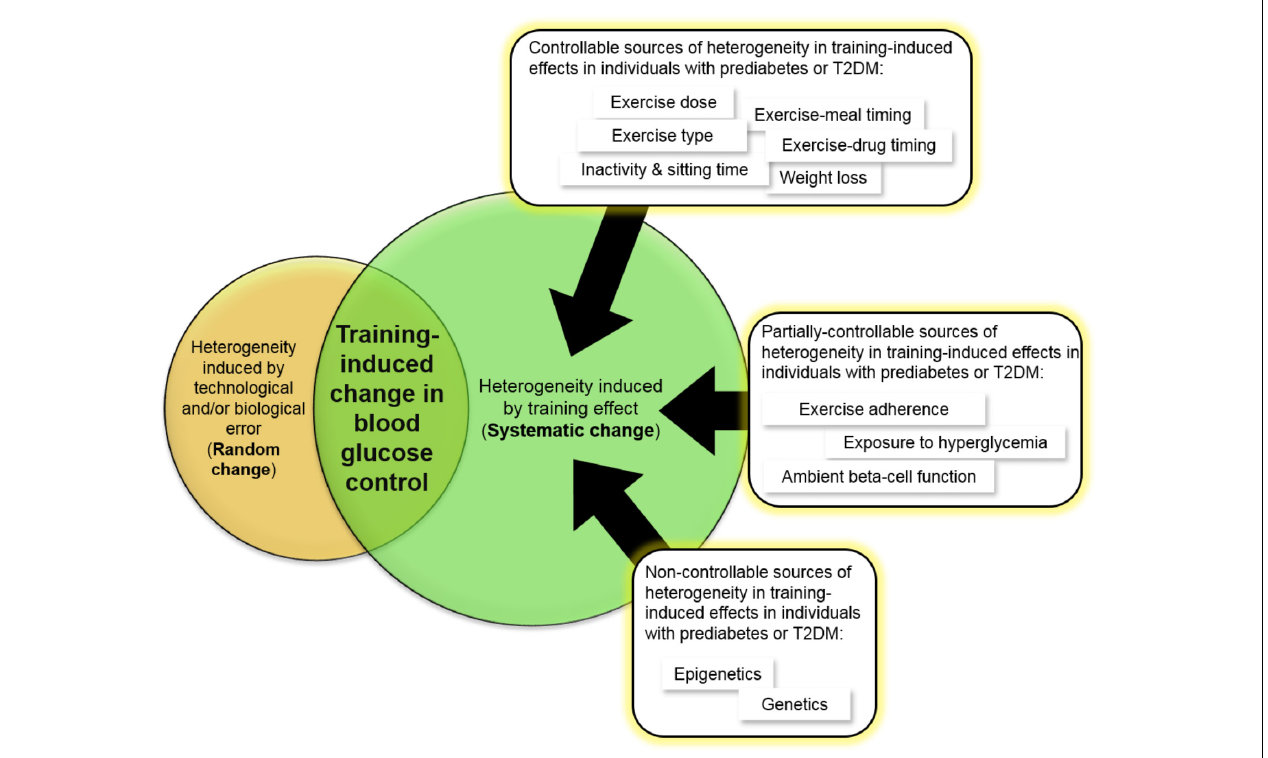
FIGURE 3 | Evidence-based sources of inter-individual variability in the blood glucose lowering effects of exercise in individuals with prediabetes or T2DM. Other sources that have not been adequately studied to conclusively state that they contribute to this variability in individuals with prediabetes or T2DM include age, sex, race, body weight, family history of diabetes, and duration of diabetes.